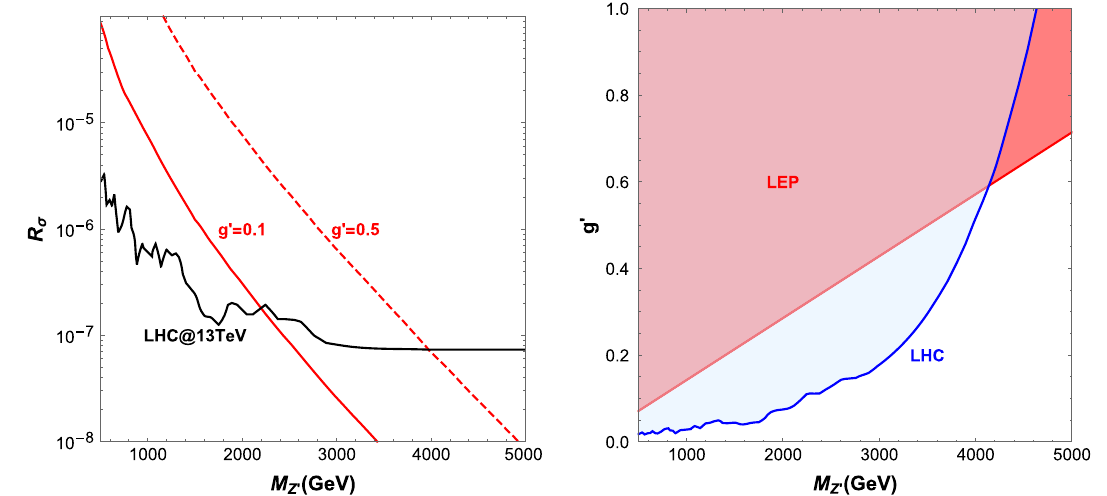
Fig. 9 Left pattern: predicted cross section ratios in U ( 1 ) B − 2 L in the g (cid:12) - M Z (cid:12) plane